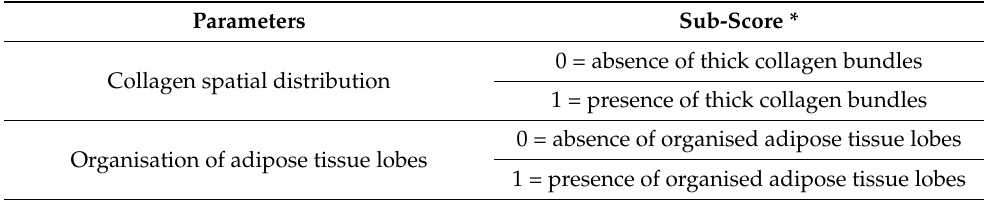
Table 2. Mesenteric collagen architectural score in colon cancer.